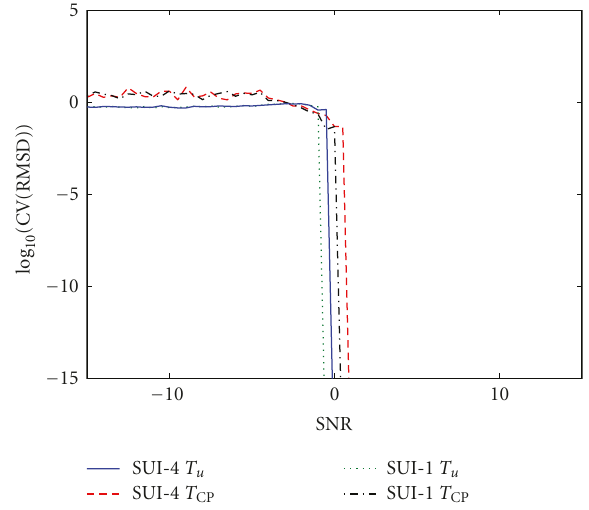
Figure 8: CV(RMSD) of the useful time interval T u and the CP duration T CP on SUI-1&4 channel models with